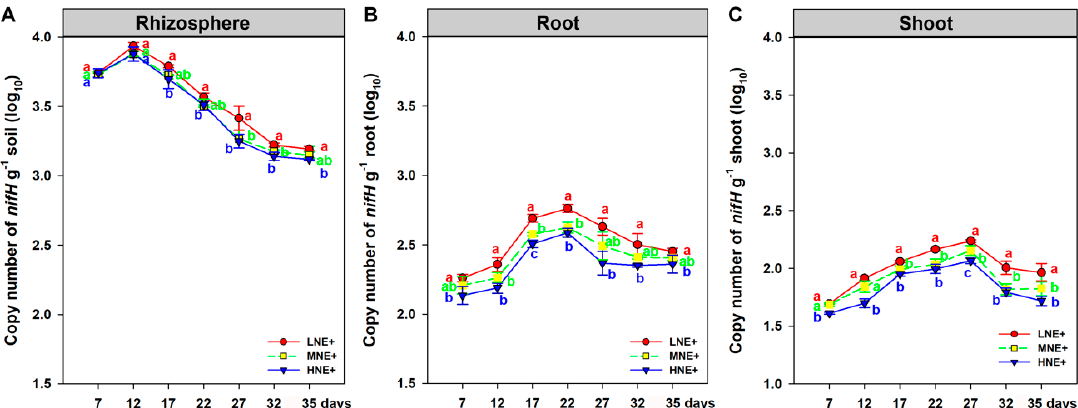
Figure 1. The population dynamics of P. triticisoli BJ-18 during the plant growth period from Days 7 to 35 in the maize rhizosphere ( A ), root ( B ) and shoot ( C ) during the plant growth period from Days 7 to 35. The population density is indicated by the copy number of the specific nifH gene determined by qPCR. The values are given as means of three independent biological replicates. Different letters (a, b and c) indicate significant differences between different N treatments at a certain day according to the LSD test ( p < 0.05).